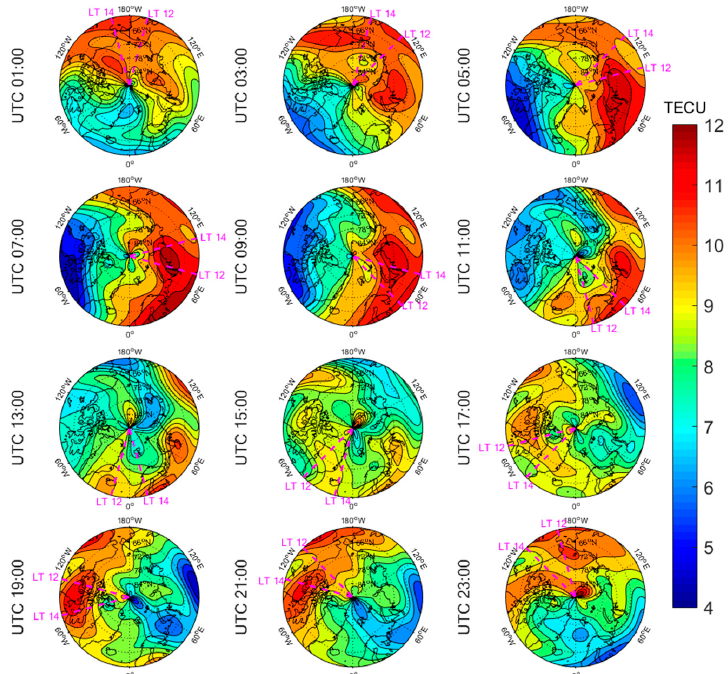
Figure 5. Spatial distribution of mapping TEC of 12 sections under low solar activity year, polar night (DOY 001 in 2010) over the Arctic. The magenta lines in each subplot represent the longitudes at 12:00 and 14:00 at the middle of the 2 h section of the corresponding subplot.